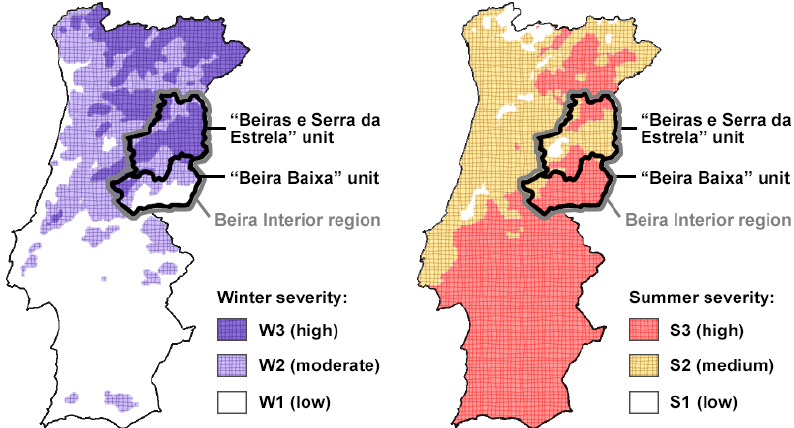
Figure 1. Portuguese climate scenarios for winter and summer seasons.